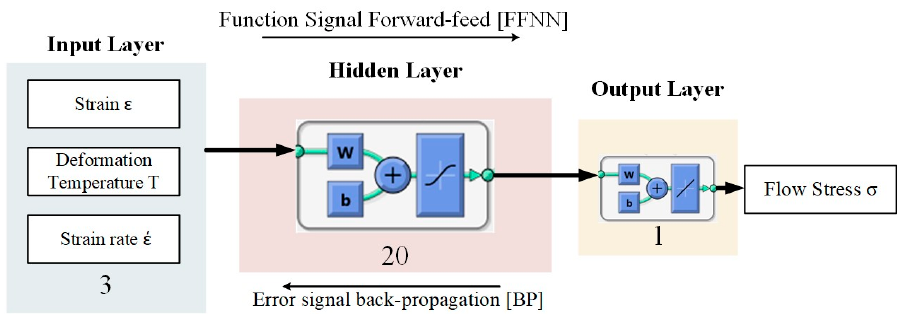
Table 2. Settings of the training parameters for the used neural network.